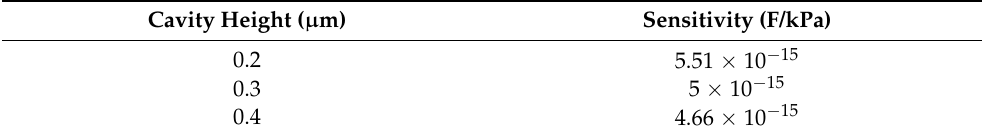
Table 4. The sensitivity of different cavity heights.